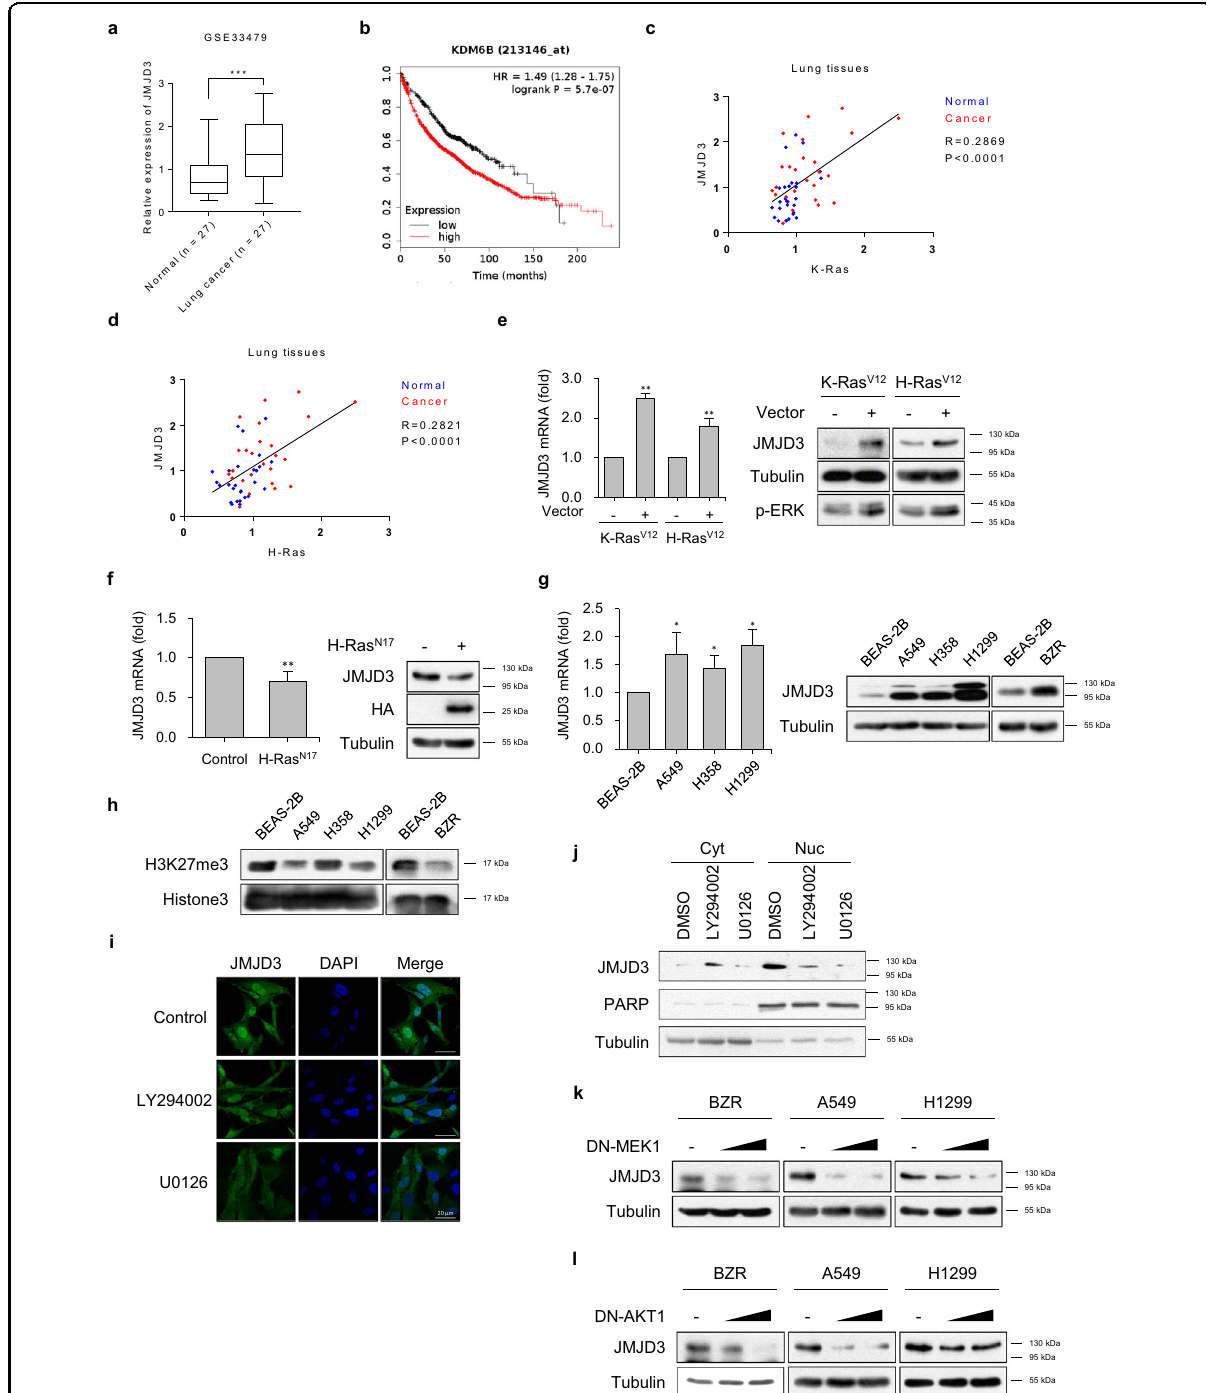
Fig. 1c, d). These results indicated that the elevated expression of JMJD3 in Ras-activated human lung can- cer cells plays an oncogenic role.